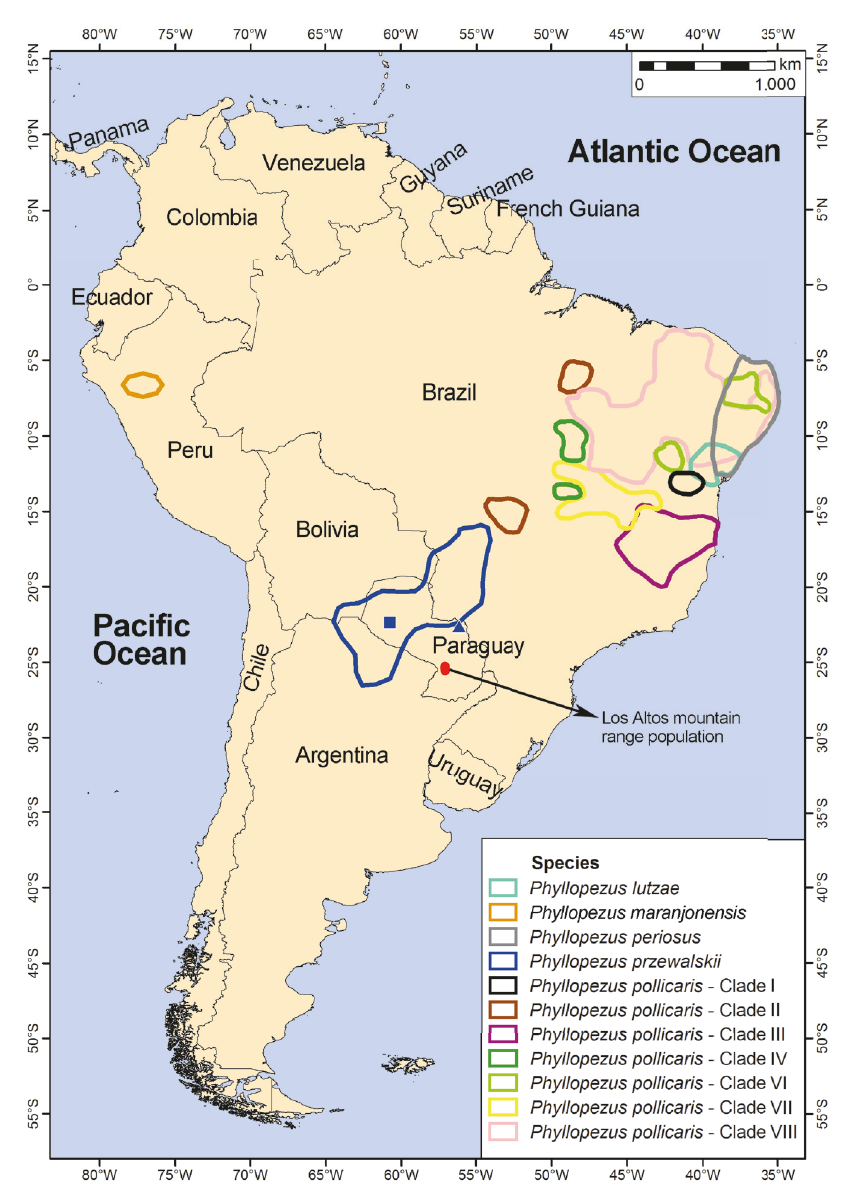
Figure 1: Distribution of the genus Phyllopezus according to Koch et al. [23] and Werneck et al. [11] indicating collection localities of our specimens. Red oval: Tobat´ı (in Los Altos mountain range). Square: Estancia La Amistad. Triangle: Parque Nacional Cerro